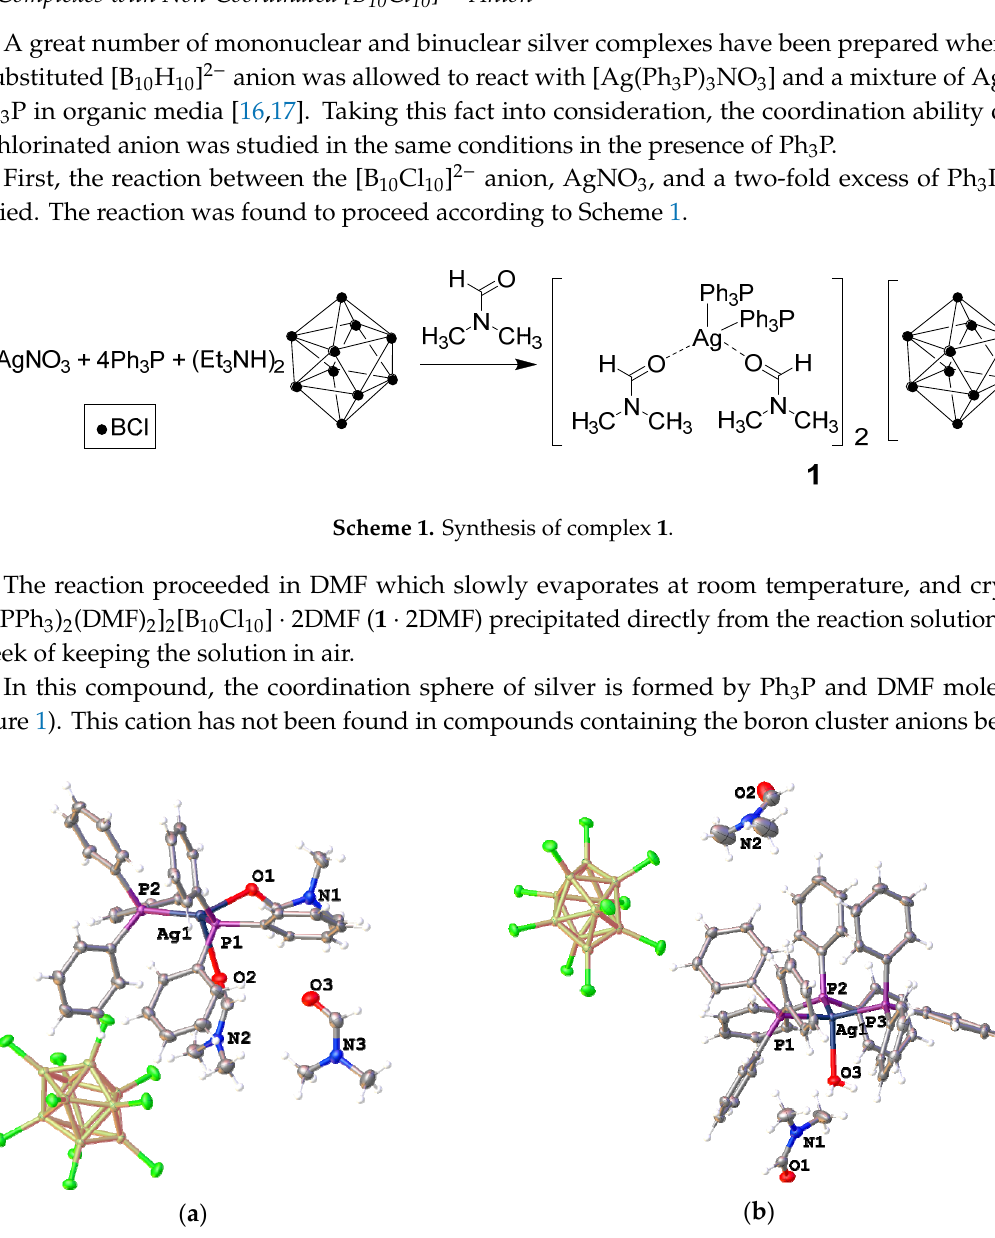
Figure 1. Molecular view of ( a ) complex 1 · 2DMF and ( b ) 2 · 4DMF in representation of atoms with thermal ellipsoids ( p = 50%). For both solids only half of the anion is symmetrically independent. When previously prepared silver complex [Ag(Ph 3 P) 3 NO 3 ] was used as the initial reagent, the reaction proceeded according to Scheme 2 and crystals [Ag(Ph 3 P) 3 (H 2 O)] 2 [B 10 Cl 10 ] · 4DMF ( 2 · 4DMF) precipitated from the reaction